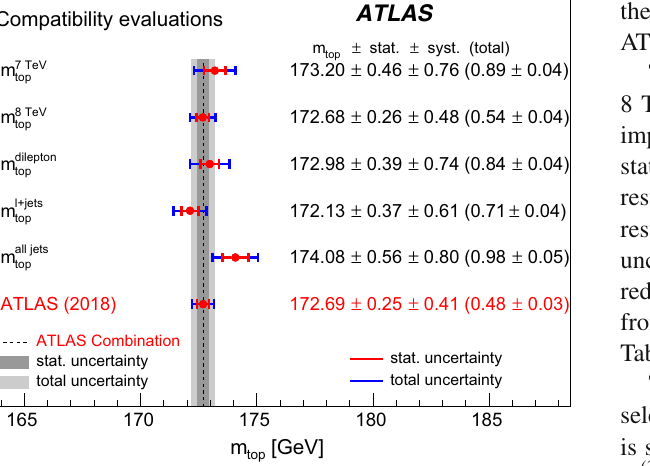
Fig. 9 The compatibility combinations performed for the six ATLAS results of m top . The figure shows the combined results listed in Table 6, which are obtained from data taken at different centre-of-mass energies and for the three decay channels, in comparison to the new ATLAS result. The values quoted are the combined value, the statistical uncer- tainty, the systematic uncertainty, the total uncertainty and the uncer- tainty in the total uncertainty. The results are compared with the new ATLAS combinationlistedinthelastlineandshown asthegreyvertical bands